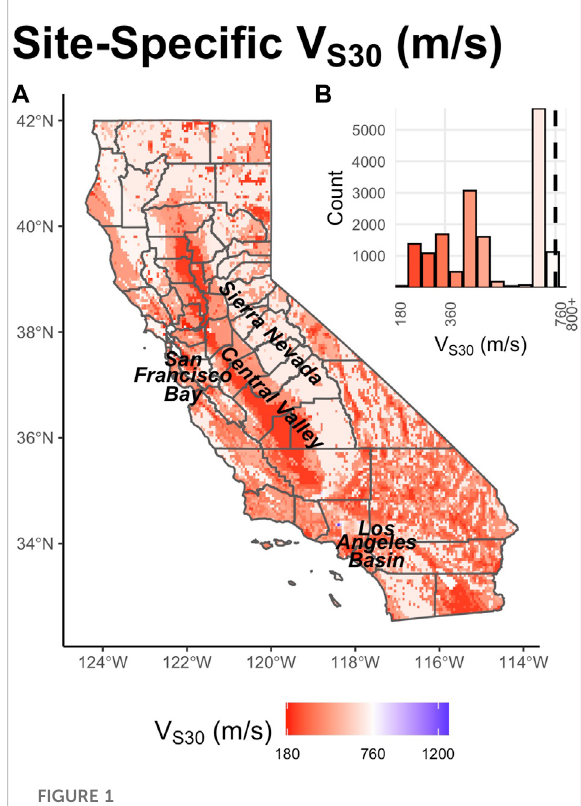
FIGURE 1 (A) Map of median V S30 in 10 × 10 km grid cells for California. (B)